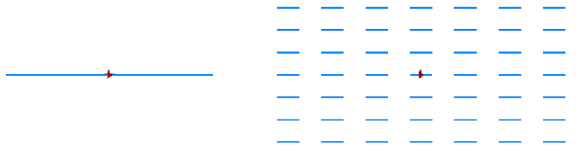
Fig. 2.Straight dipole (left panel) and array of 7x7 straight elements (the central one is fed) (right panel) Fig. 3 shows the behavior of the antenna impedance of both the isolated and the wire surrounded by the passive ones in the frequency range 8-16